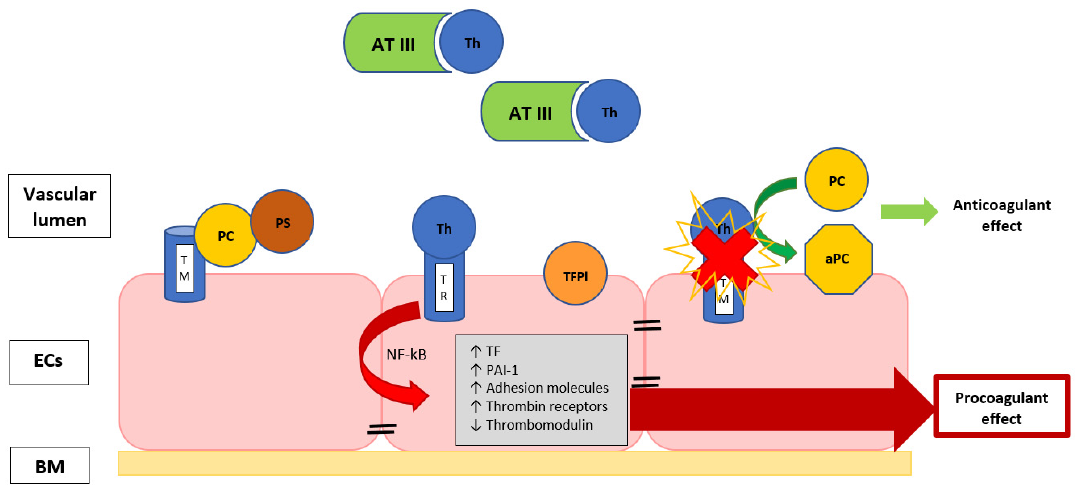
Figure 1. The image describes the EC surface with thrombomodulin, a thrombin-binding protein that is responsible for thrombin activity inhibition. When thrombin is bound to TM, they form an activator complex for PC, conferring the anticoagulant properties. The exposure to inflammatory and/or septic stimuli rapidly causes the internalization of TM or the release of inactivated TM, favoring the thrombin binding with its receptor, leading to the endothelial modulation ability towards a procoagulant state. Th, thrombin; TR, thrombin receptor; TM, thrombomodulin; AT III, antithrombin III; TFPI, tissue factor pathway inhibitor; NF- κ B, nuclear factor- κ B; PAI-1, plasminogen activator inhibitor; TF, tissue factor; BM, basal membrane; ECs, endothelial cells; PC, protein C; aPC, activated protein C; PS, protein S.